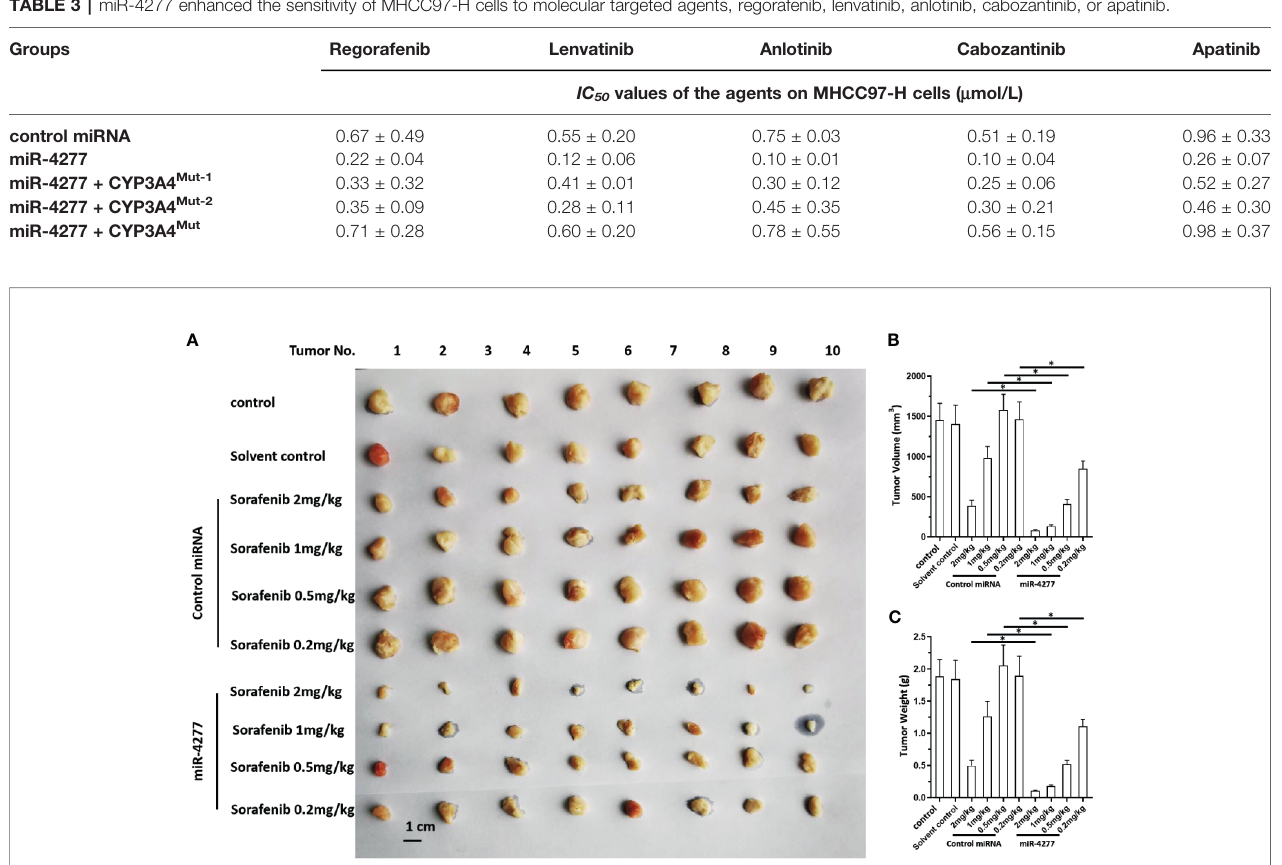
FIGURE 5 | miR-4277 enhances the antitumor effects of sorafenib in inhibiting the growth of HCC cells in a nude mouse model. MHCC97-H cells were transfected with vectors (control miR or miR-4277) and subcutaneously injected into nude mice. The mice then received the indicated dose of sorafenib via oral administration. The results are shown as tumor images (A) , tumor volumes (B) , or tumor weights (C) . *P <